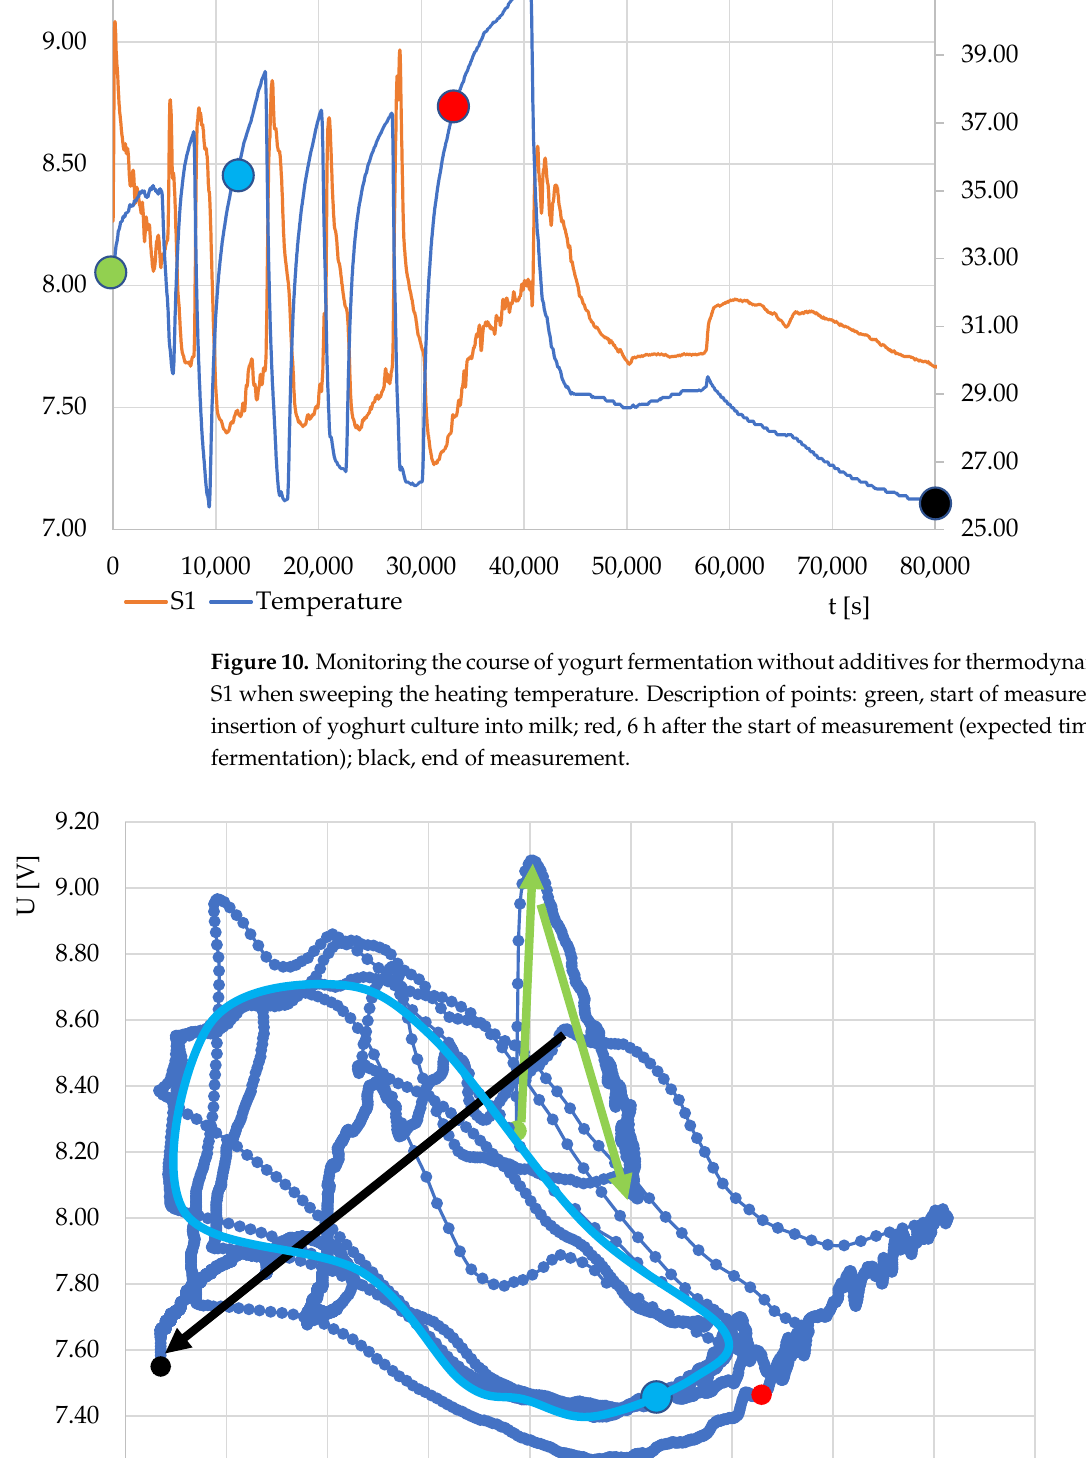
Figure 11. Dependence of output voltage on temperature during individual phases of fermentation in yoghurt production for thermodynamic system S1. Description of the meaning of colors in arrows and points: green point, start of measurement; green arrow, temperature stabilization; blue point, insertion of yogurt culture into milk; blue loop, course of dependence during fermentation; red point, 6 h after start of measurement (estimated time end of fermentation); black arrow, end of fer- mentation; black point, end of measurement.